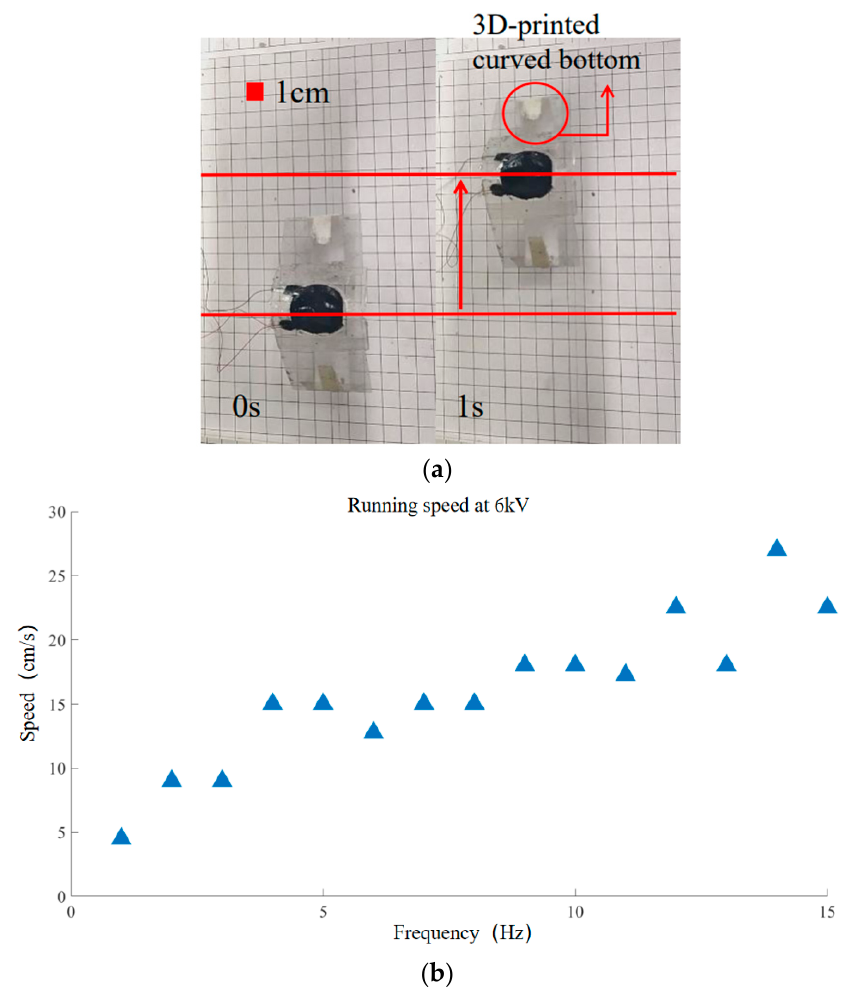
Figure 8. Forward running experiment. ( a ) Running experiment after counterweight. Red line positioning robot is used to indicate the forward direction of robot; ( b ) Running speed of 1–15 Hz at 6 kV.